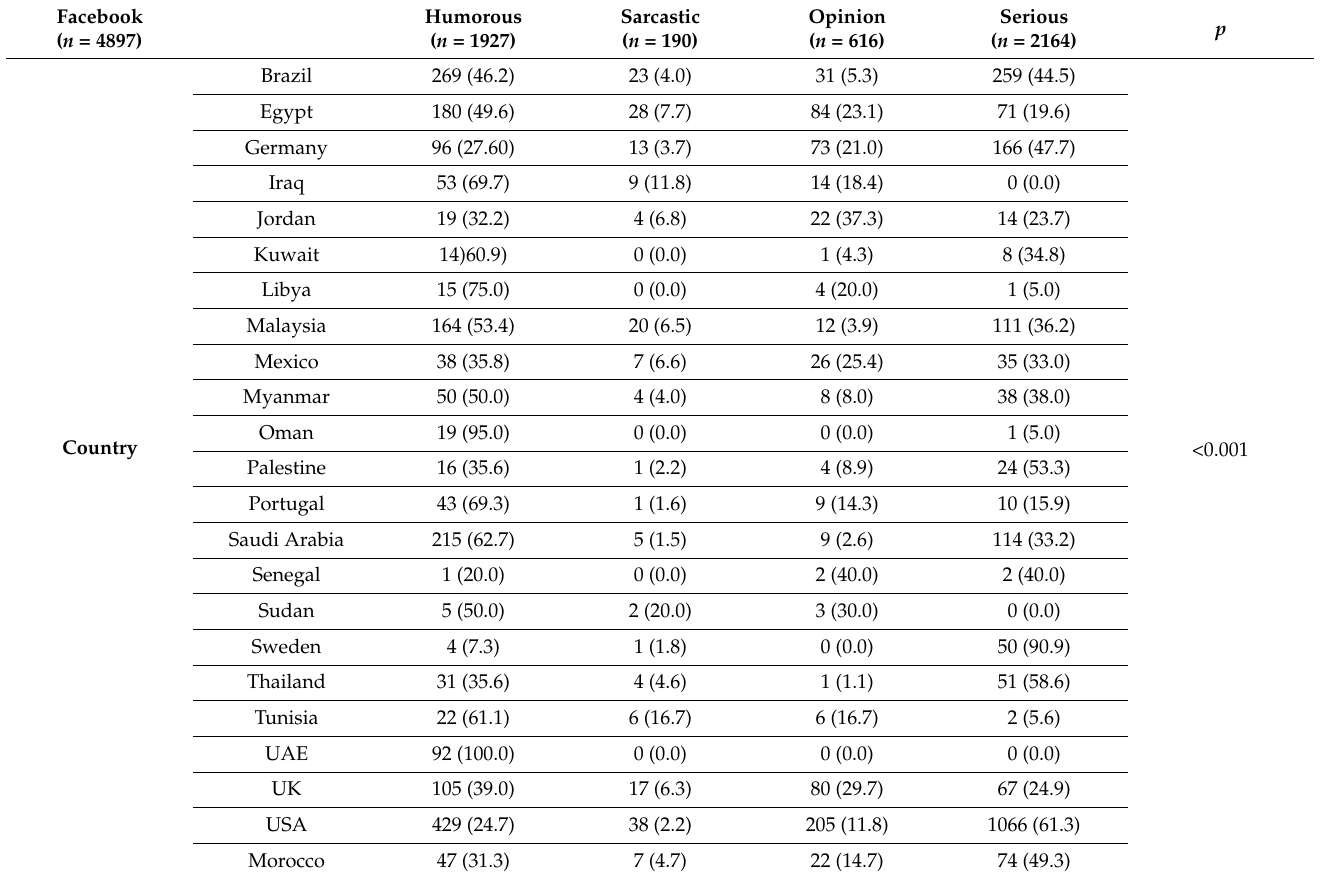
Table 3. Country-Tone in